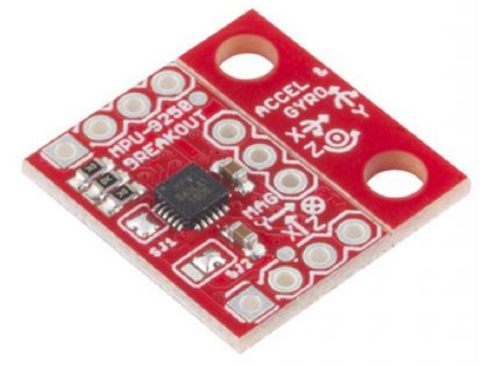
Figure 20. SparkFun MPU-9250 (Breakout